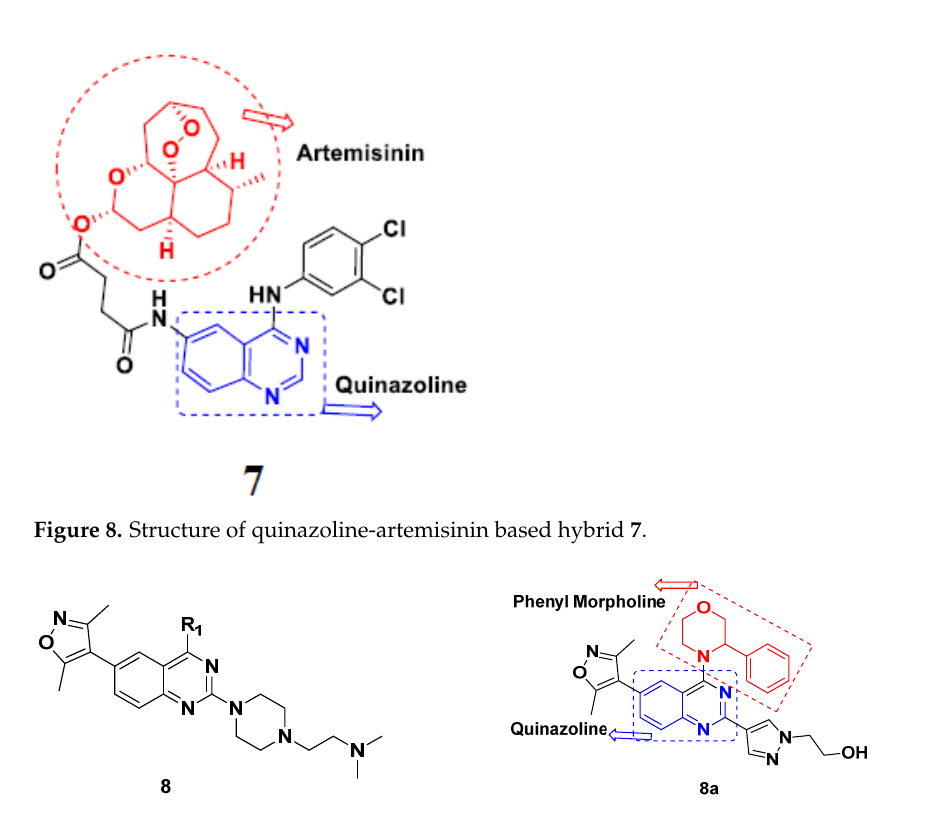
Figure 9. Structure of quinazoline phenyl morpholine based hybrids and the most promising com- pound 8a. Table 7. In vitro cytotoxic activities of hybrid compounds 8 ( b – e ).